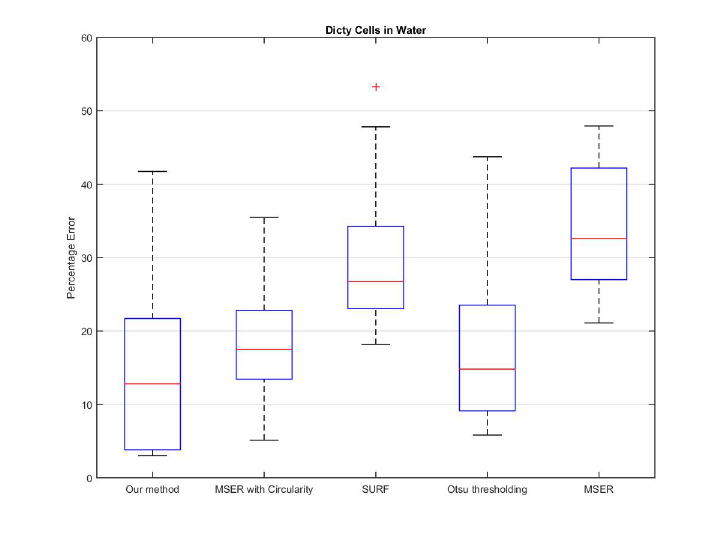
Figure 23. Performance comparison of different perception methods for dicty cells and silica beads in